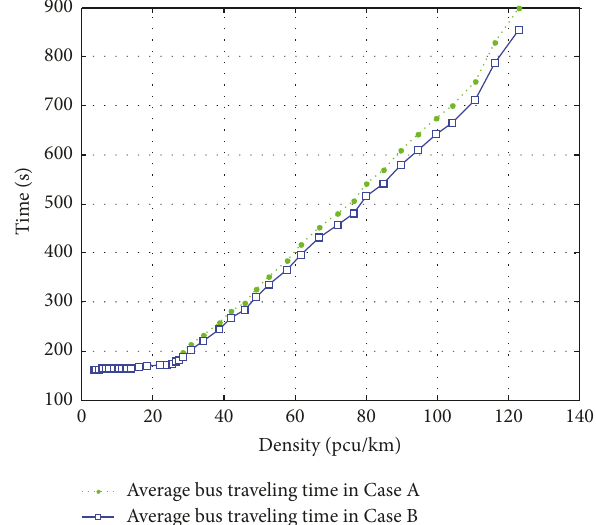
Figure 6: Average bus traveling time in Case A and Case B in different traffic density